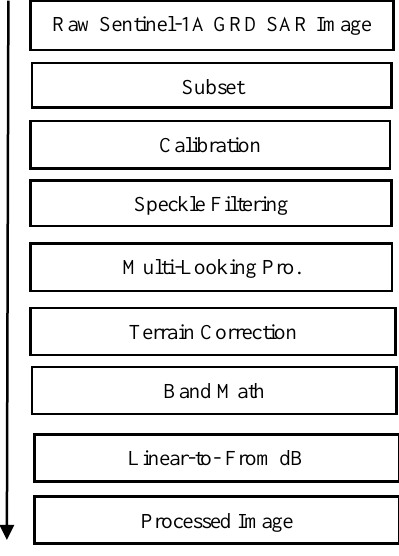
Figure 2. Pre-processing Steps of Sentinel-1A GRD SAR